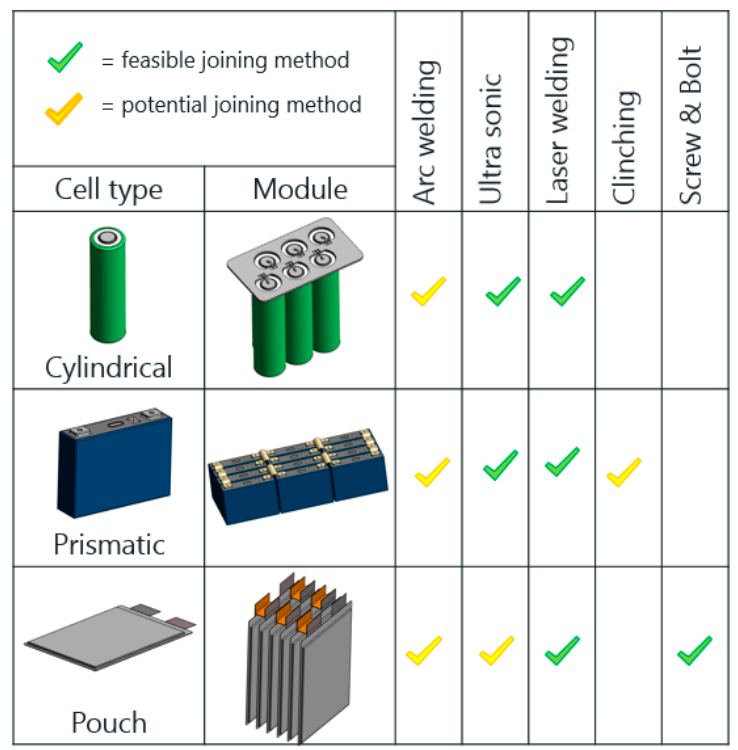
Figure 3. Commercially available cell and module types with electrical contact joining methods.